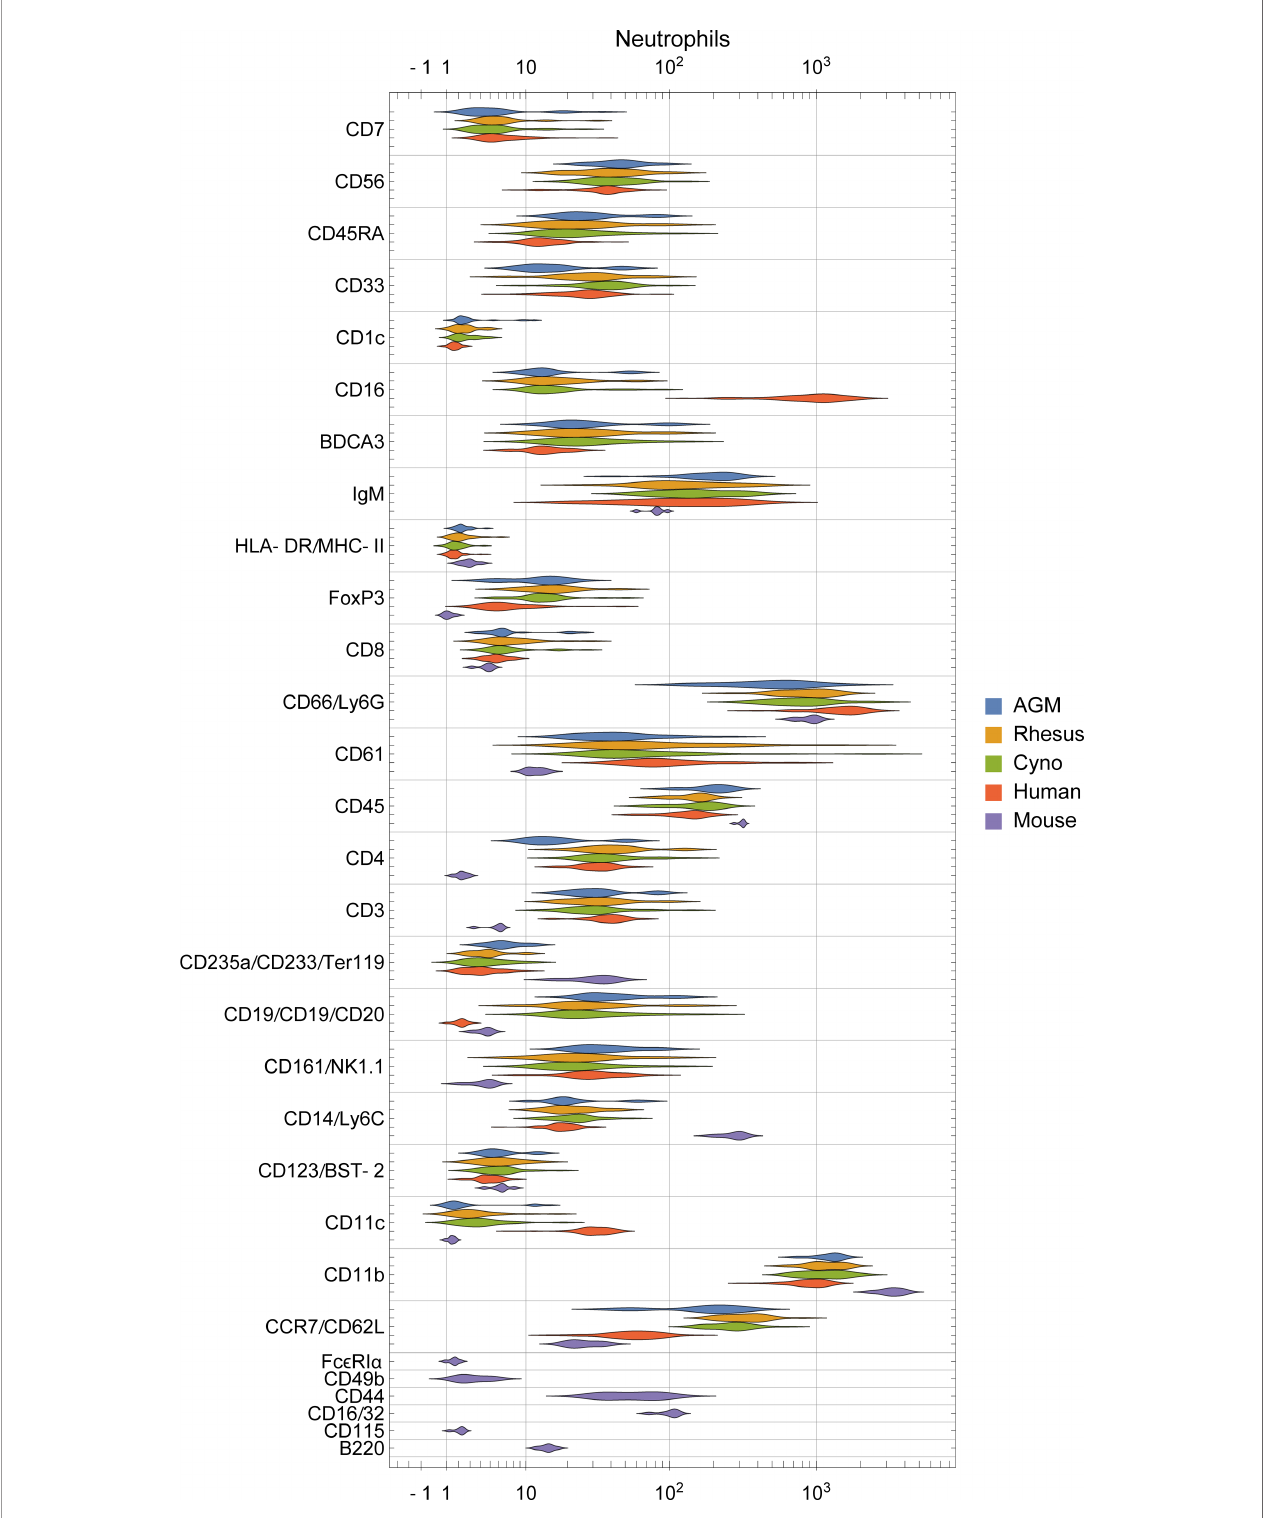
FIGURE 4 | Distribution of surface marker expression for each species in neutrophils. (See Figure S3 for other populations). Different markers are grouped together if they were on the same channel and stain similar cell types between species (e.g. CD235a/CD233/Ter119 are all on In113 and stain erythrocytes), and are labeled as “ [all species] ” , “ [primates]/[mice] ” , or “ [humans]/[non-human-primates]/[mice] ”